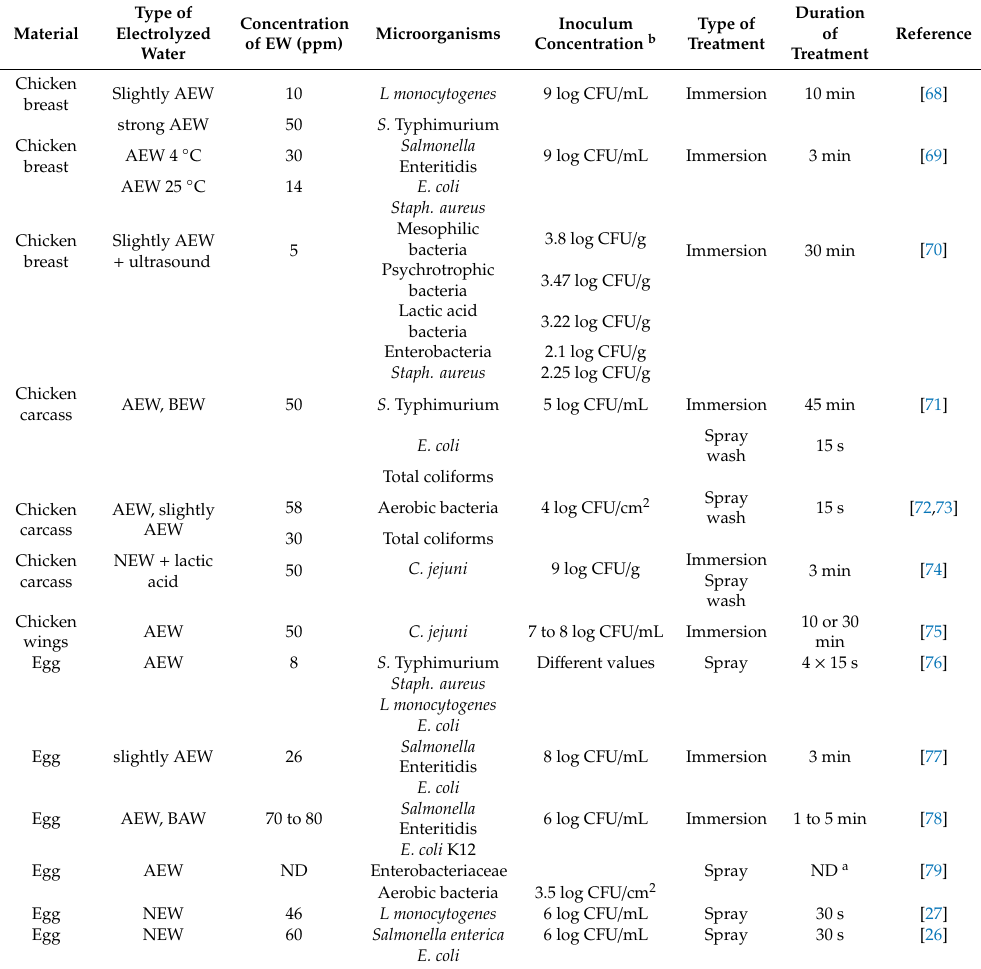
Table 4. Evaluations of electrolyzed water in